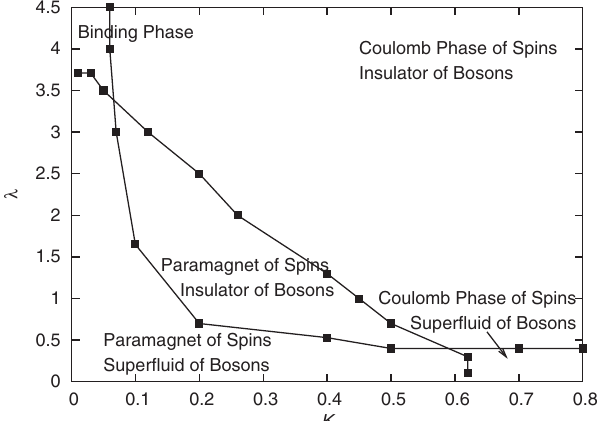
FIG. 14. Bulk phase diagram for the model described in Eqs. (23) and (50), with d ¼ 3 and small β ¼ 0 . 1 . We can compare this to the case of d ¼ 1 , where the middle phase is absent and the phase boundaries are straight vertical and horizontal lines, and to d ¼ 2 , where the middle phase is absent and there is a line of phase transitions between the paramagnet or superfluid phase in the lower left-hand corner and the Coulomb or insulator phase in the upper right-hand